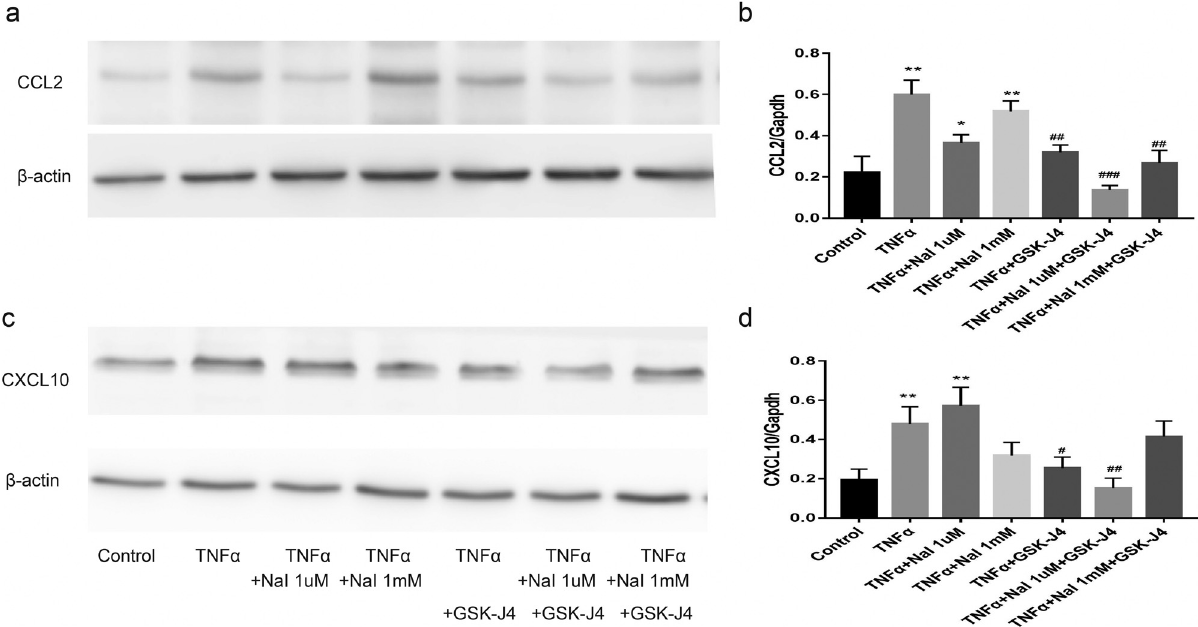
Figure 4: The e ff ects of GSK - J4 on the chemokines of thyroid cells under the action of TNF - α . ( a ) WB to evaluate Protein expression of CCL2. ( b ) Histogram representation of CCL2 protein levels. ( c ) WB to evaluate Protein expression of CXCL10. ( d ) Histogram representation of CXCL10 protein levels. * P < 0.05, ** P < 0.01 vs control group; # P < 0.05, ## P < 0.01, ### P < 0.001 vs TNF - α stimulation without GSK -